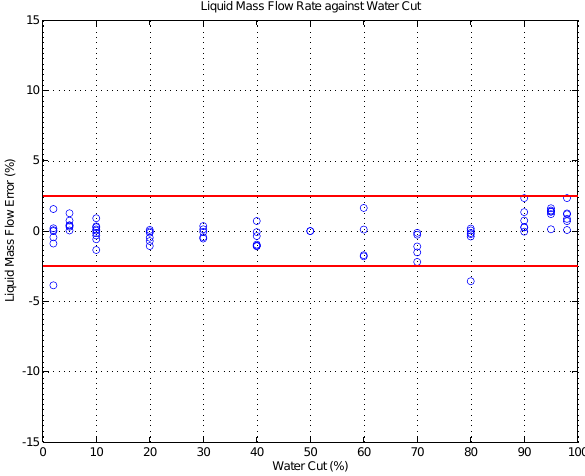
Figure 5. Total liquid mass flow rate errors against water cut. The target limit is ± 2.5% (red